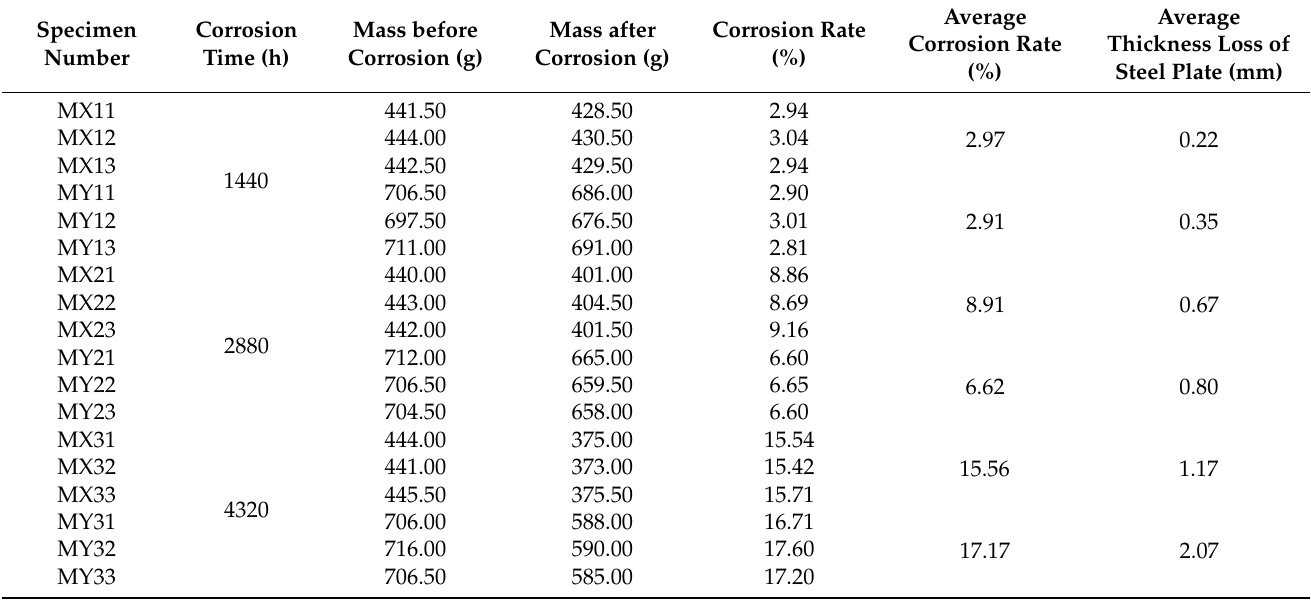
Table 4. Corrosion rate of steel plates.